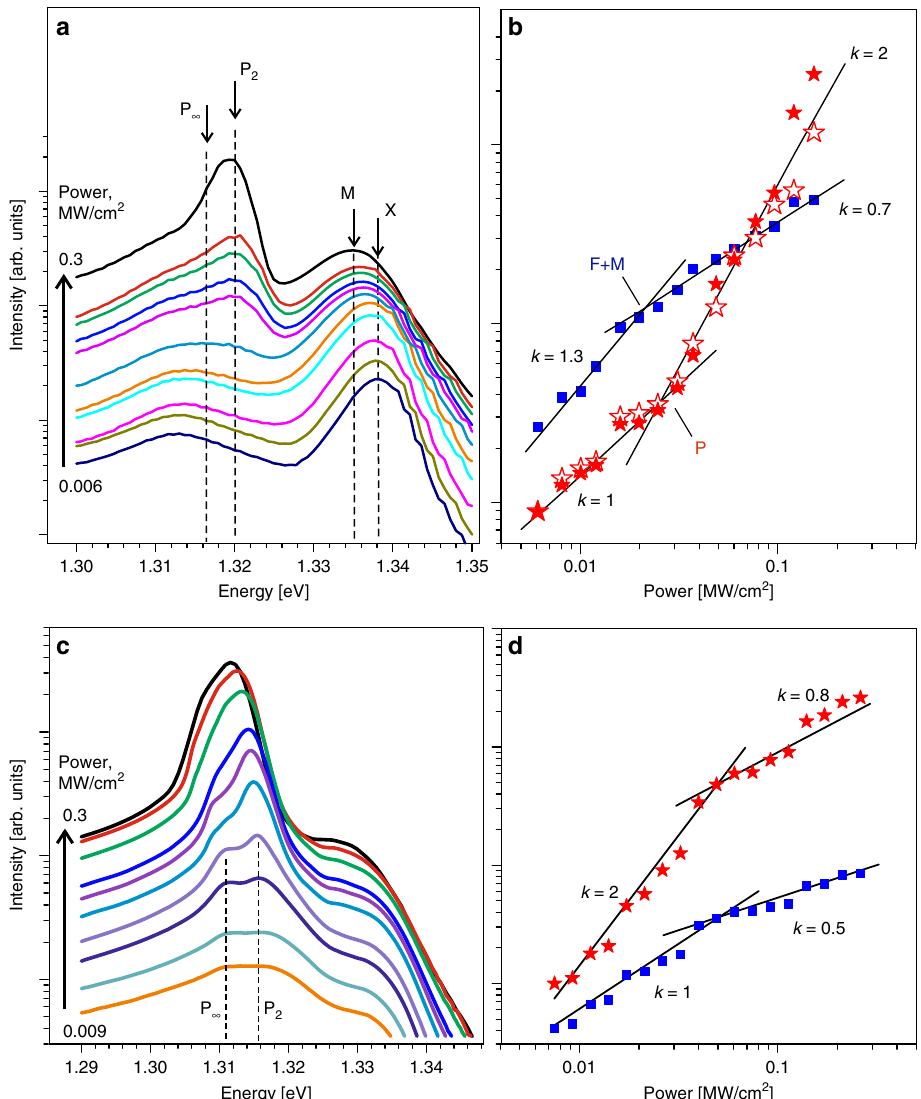
Fig. 2 Excitation power dependence of photoluminescence. a , c Selected PL spectra measured at different excitation powers (log scale) in undoped ( a ) and doped ( c ) InSe samples. b , d Power dependencies of integral PL intensity shown for the joint X + M peak (blue squares) and P-band (red stars) in the undoped ( b ) and doped ( d ) InSe. Black lines show fi ttings with the exponents marked nearby. In ( b ), solid and open red stars present the P-band data obtained, respectively, as for a whole band and as a sum of two